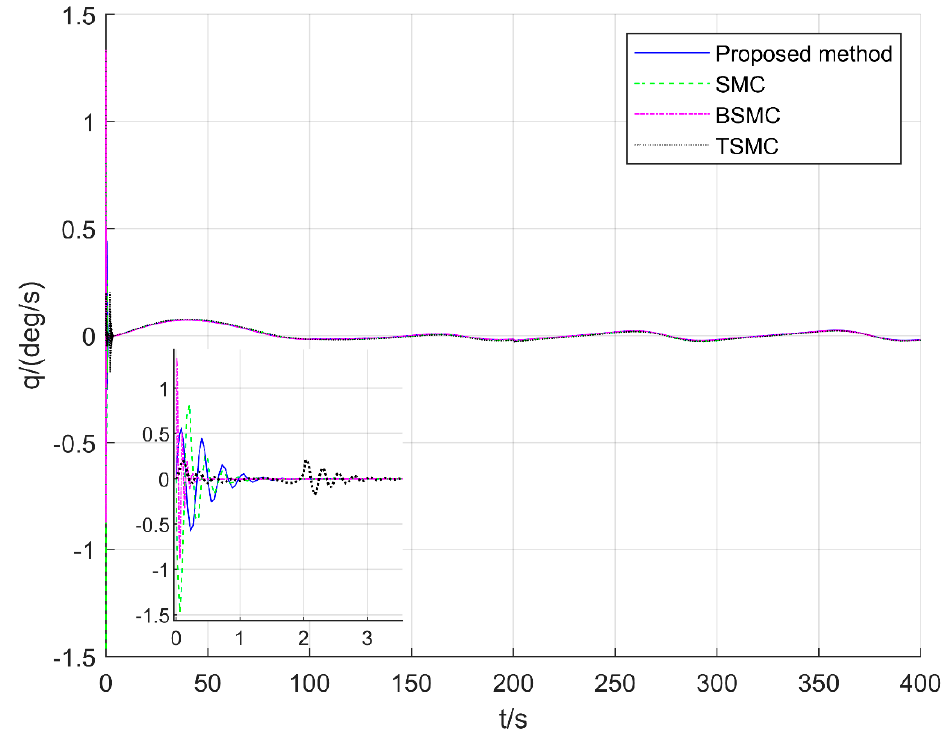
Figure 11. Responses of pitch angle rate.